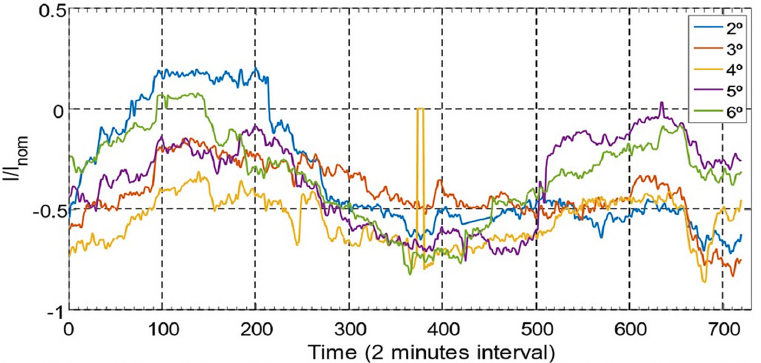
Figure 26. First week of July: evolution of load factor for different working days (2nd to 6th).